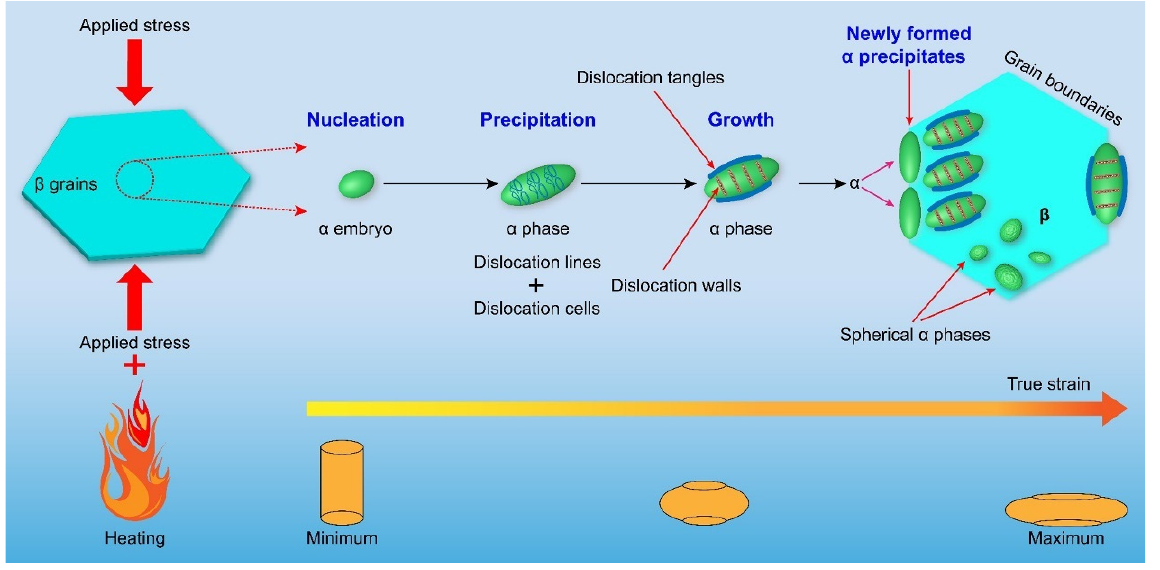
Figure 8. Schematic diagram of precipitation behavior for α phase during isothermal compression.